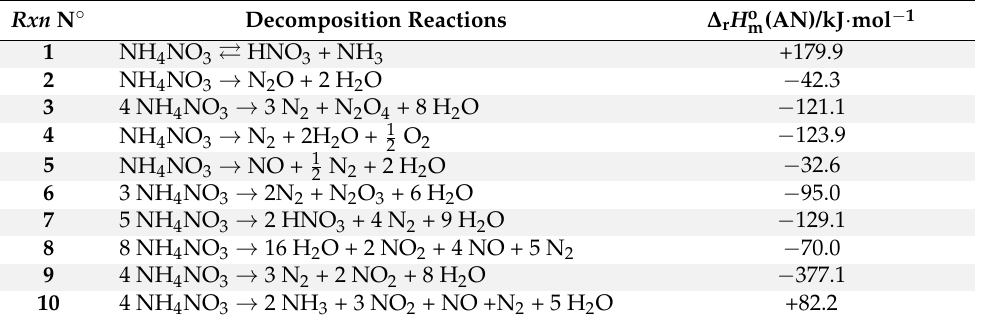
Table 3. Single-step decomposition reactions of AN (positive values of heat of reaction indicate endothermic reactions, negative values exothermic). The reaction heat, ∆ r h , is expressed at T = 298.15 K [46]. “Reprinted/adapted with permission from Ref. [46]. 2022, John Wiley”. Rxn N ◦